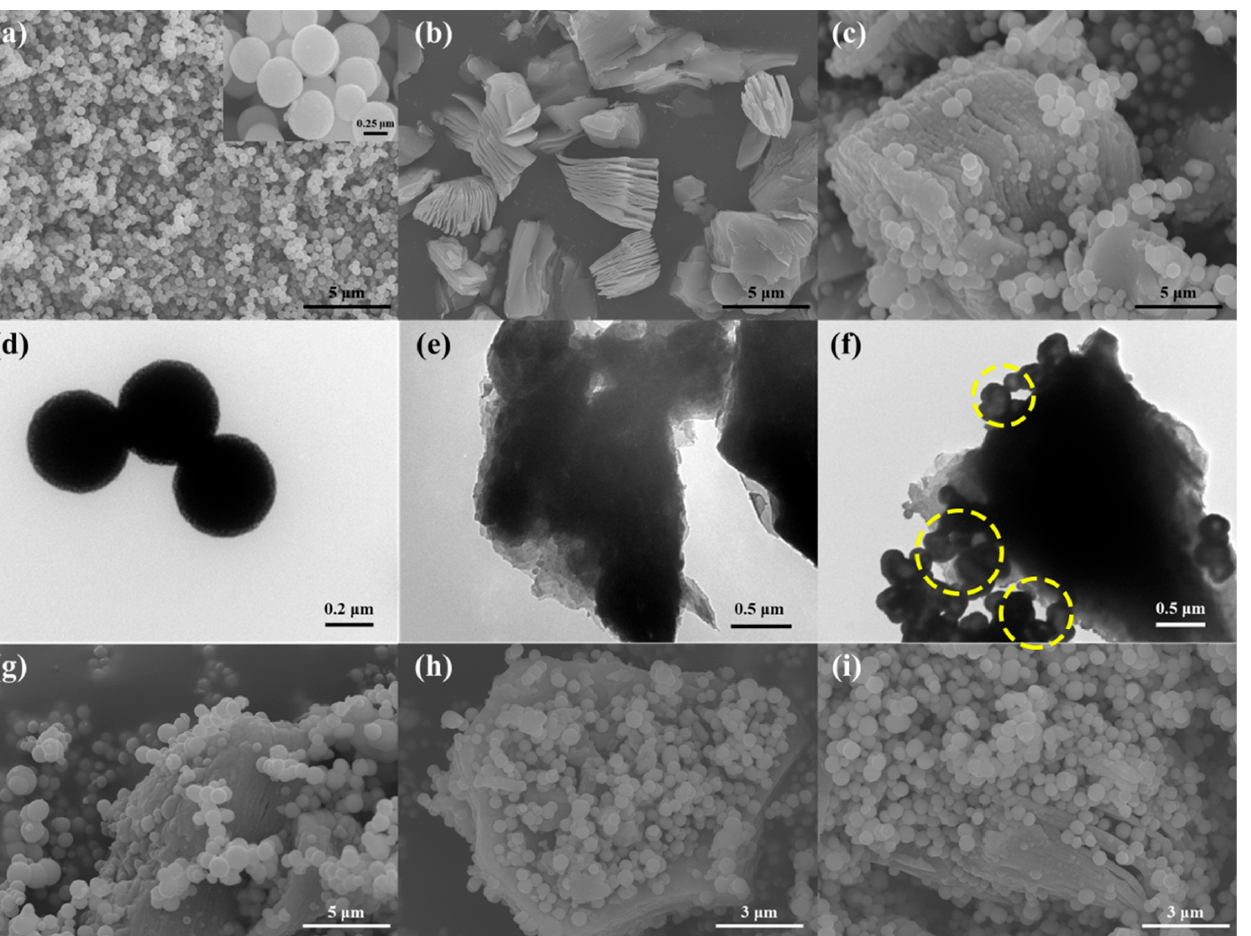
Figure 3. ( a – c ) SEM of SnO 2 , multilayer MXene and SM-5; ( d – f ) Corresponding TEM diagrams of SnO 2 , multilayer MXene and SM-5; ( g – i ) SEM images of different material ratios SM-10, SM-5 and